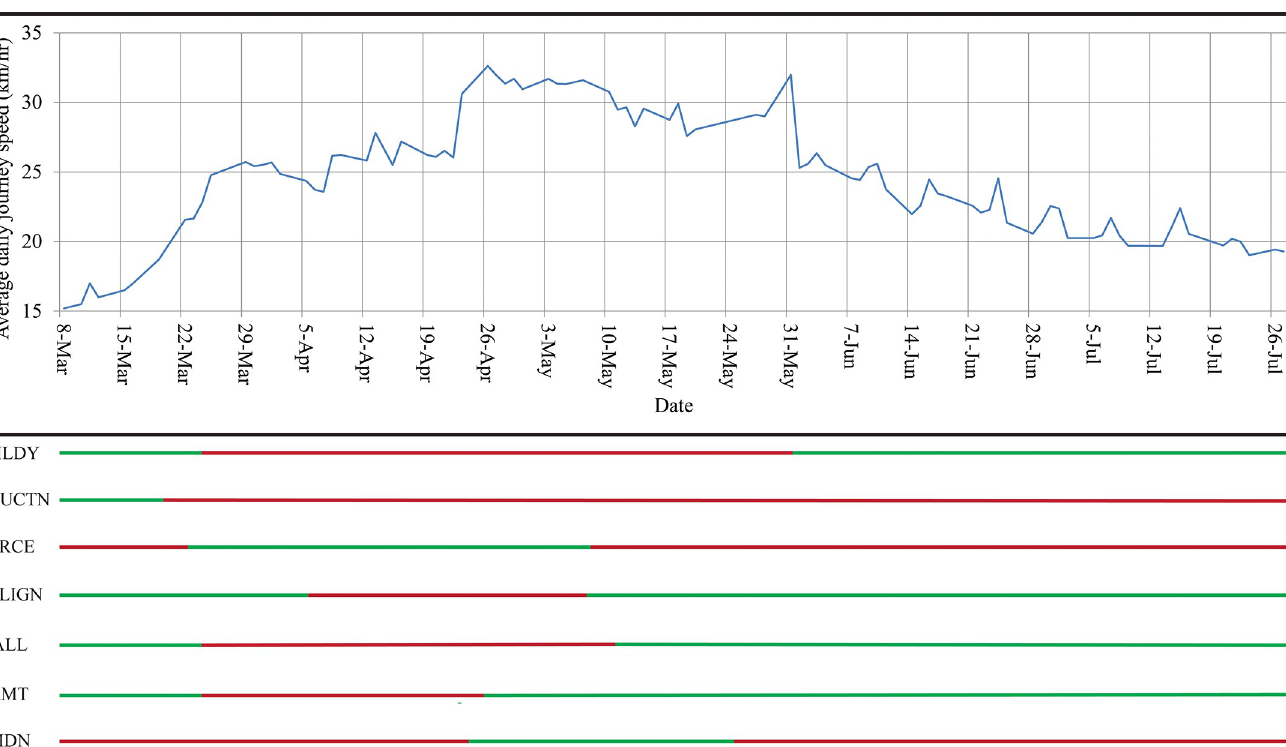
Fig 3. Average daily journey speed ( ADJS) by date as well as containment strategies and the month of Ramadan. (Here, for the chart portion, blue line is the trend line. Whereas, in the containment strategies portion, red line means variable value= 0 and green line means variable value= 1 according to Table 1 ).